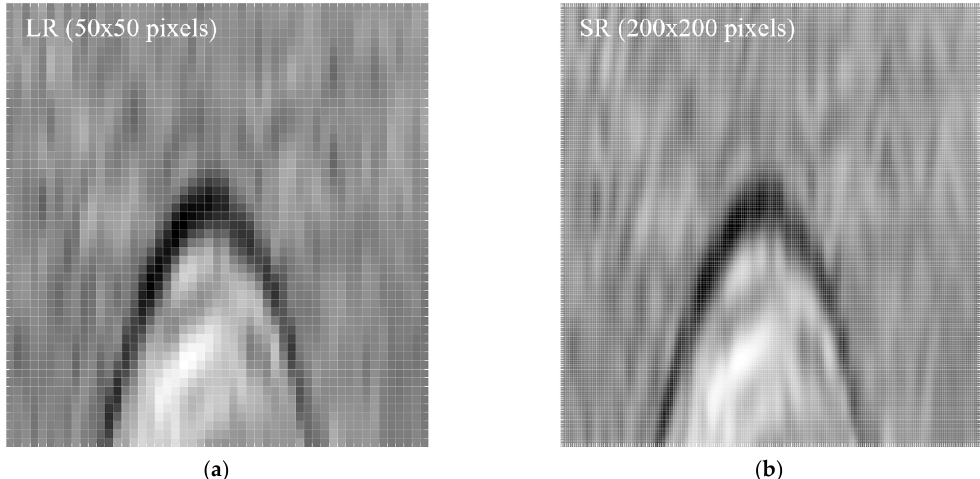
Figure 4. Representative LR GPR image for SR image generation input.